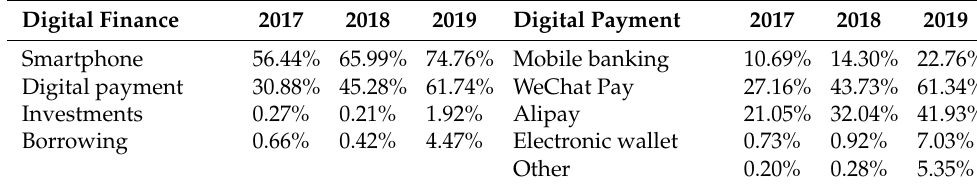
Table 1. The use of digital finance and digital payment by rural households.